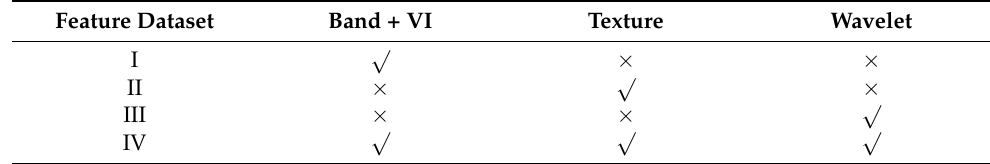
Table 3. Description of the four feature